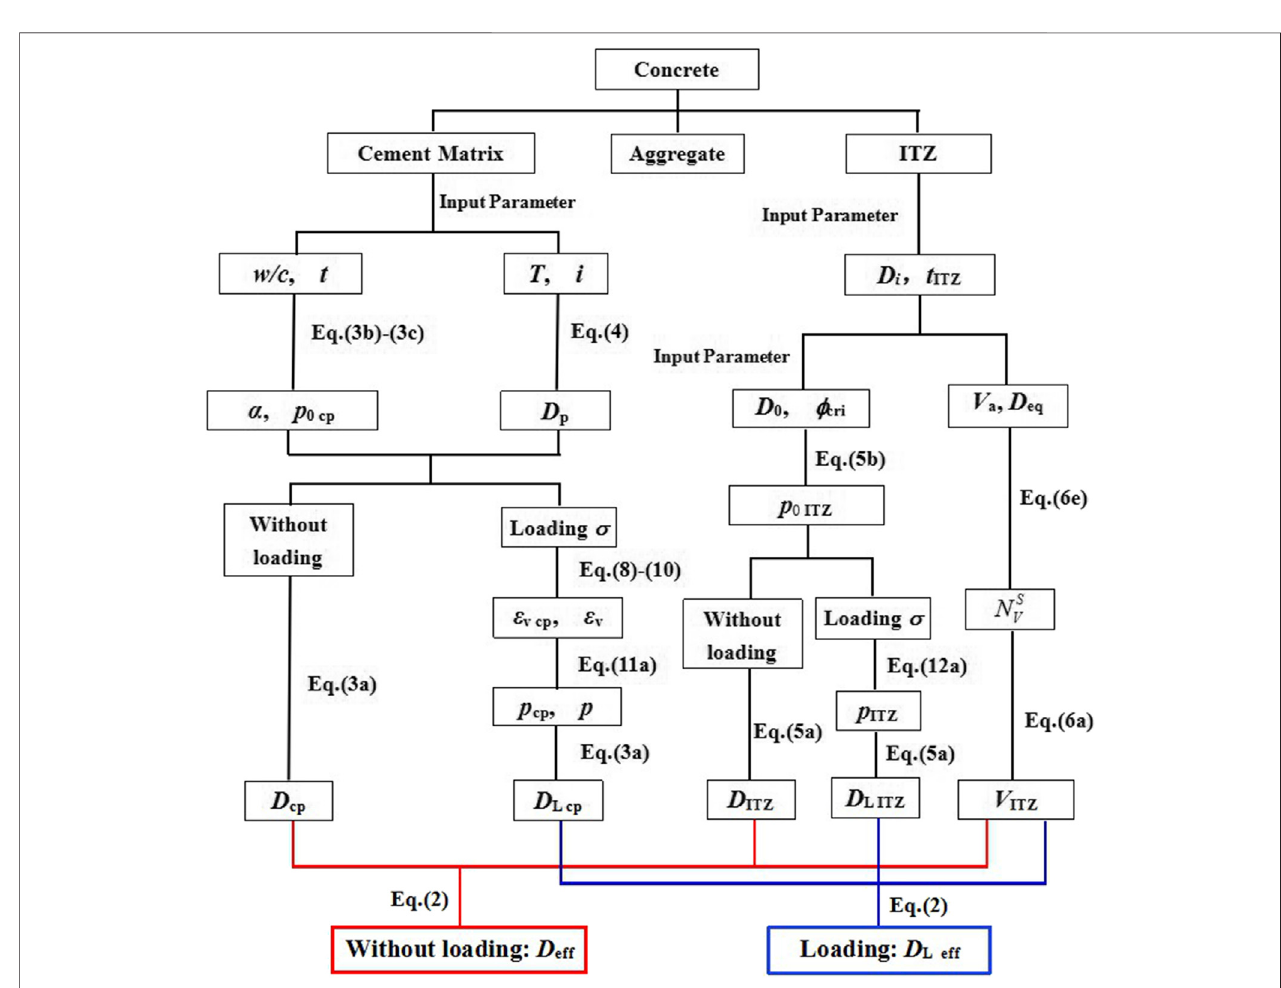
FIGURE 4 | Calculation fl owchart of effective diffusion coef fi cient of chloride under bending load.